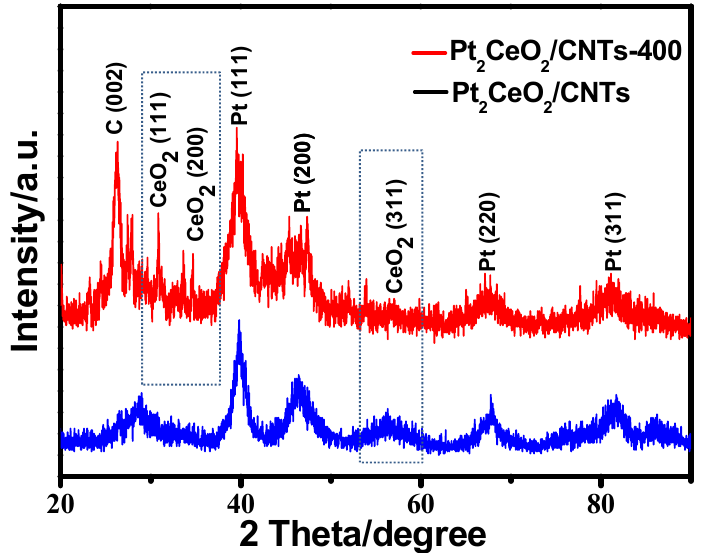
Figure 1. XRD patterns of Pt 2 CeO 2 /CNTs and Pt 2 CeO 2 /CNTs-400 catalysts. Figure S1 from Supplementary Materials shows the XRD patterns of Pt 2 CeO 2 /CNTs-300 and Pt 2 CeO 2 /CNTs-500 catalysts. The average crystallite size of the Pt nanoparticles was determined to be 4.5 ± 1.14, 4.5 ± 1.06, 4.3 ± 1.07 and 4.4 ± 1.11 nm for the Pt 2 CeO 2 /CNTs-400, Pt 2 CeO 2 /CNTs-300, Pt 2 CeO 2 /CNTs-500 and Pt 2 CeO 2 /CNTs, re-